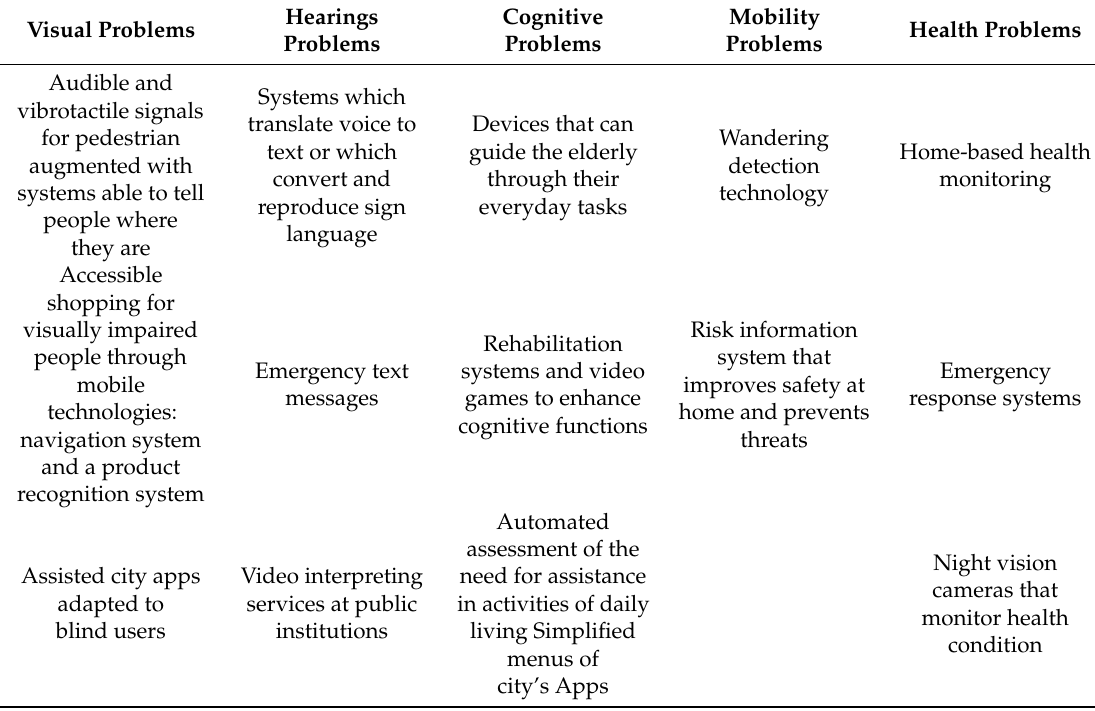
Table 1. Smart city solutions targeting older